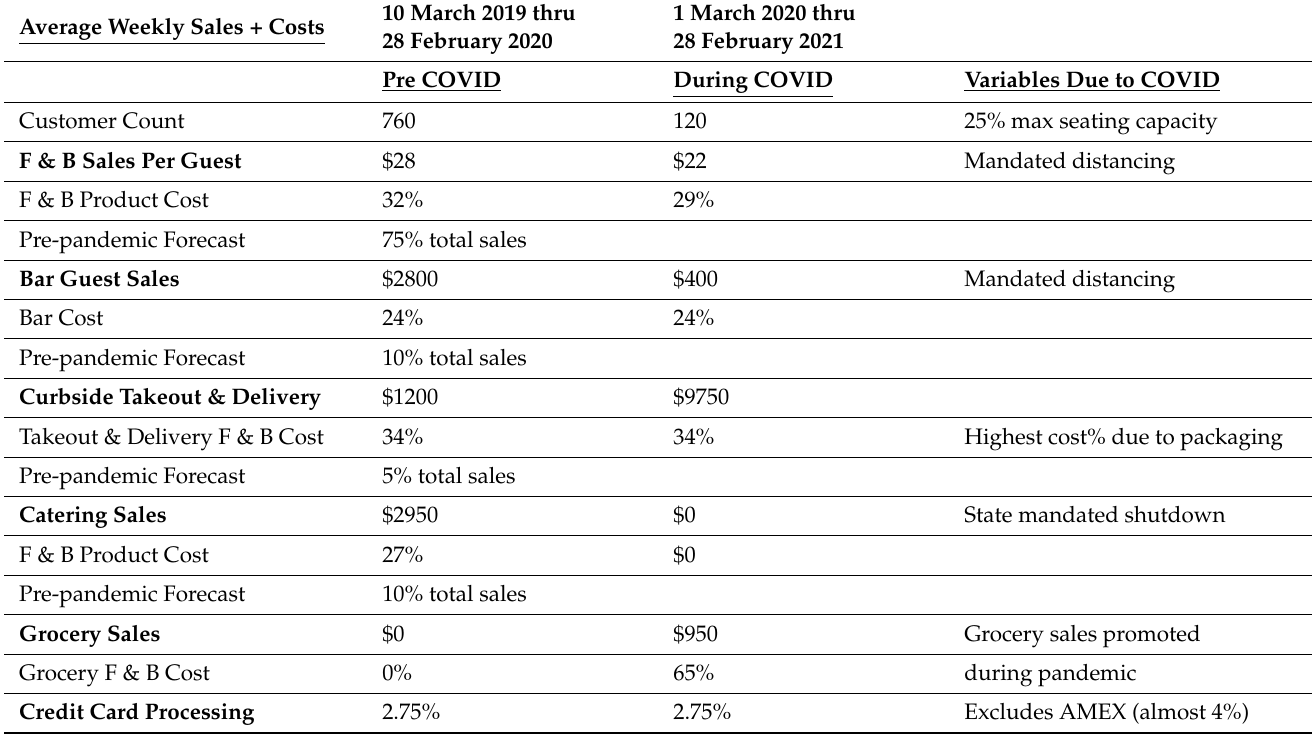
Table 1. Average weekly sales revenue and operational costs prior to COVID-19 versus during the first year of COVID-19. These are a composite of the sales statistics of three actual restaurants located in Long Island, New